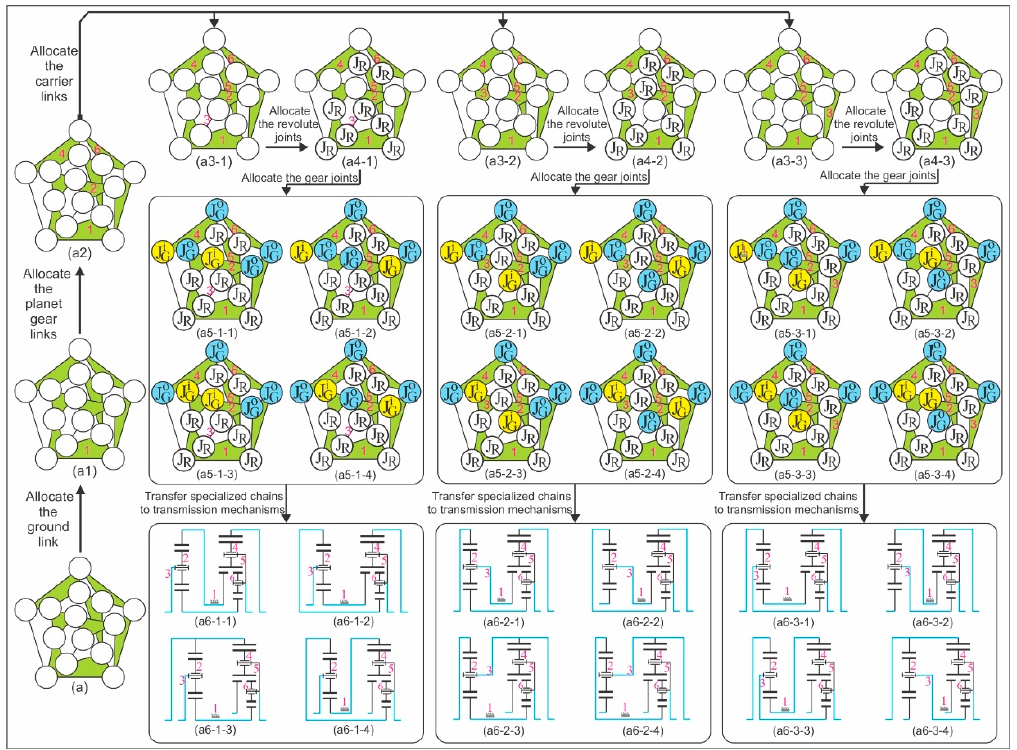
Figure 6. Specialization process for GKCs.